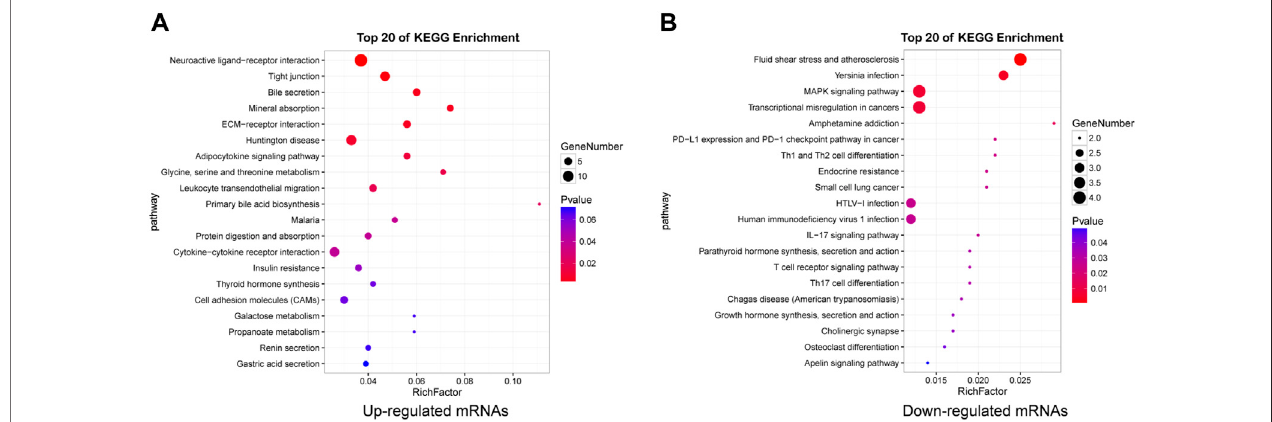
FIGURE 5 | Detailed information for the top 20 KEGG pathways. Pathway enrichment analysis of upregulated (A) and downregulated (B) mRNAs in HE mice.